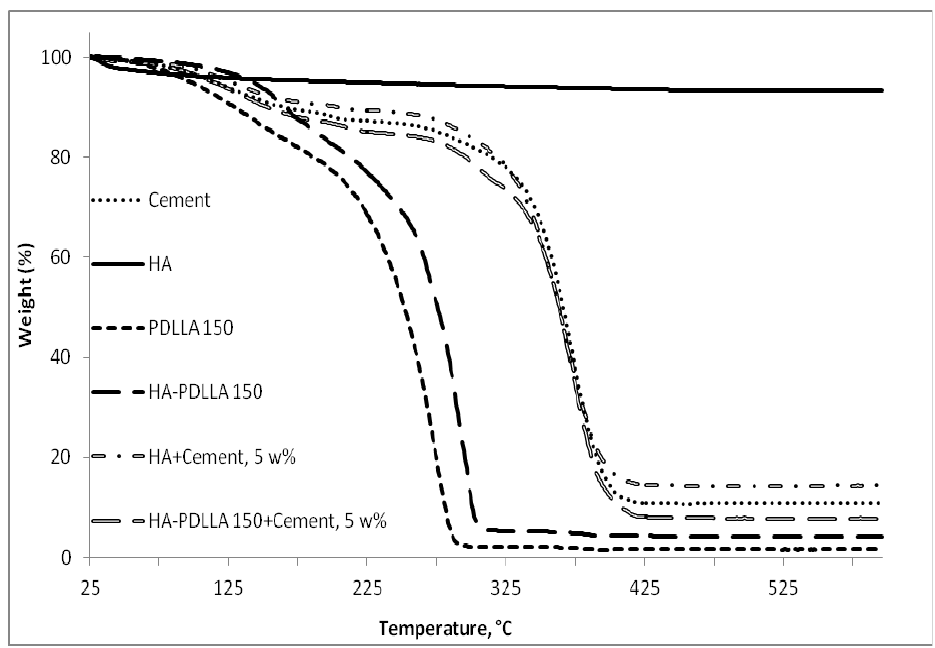
Figure 12. TGA thermograms of Simplex P SpeedSet radiopaque bone cement (Cement); hydroxyapatite (HA), poly(lactide) at (M):(C) = 150 (PDLLA 150), hydroxyapatite-polylactide grafts at (M):(C) = 150 (HA-PDLLA 150), and physical mixtures at 5 % weight ratio of: hydroxyapatite + Simplex P SpeedSet (HA + Cement) and HA-PDLLA 150 + Simplex P SpeedSet (HA-PDLLA 150 + Cement).